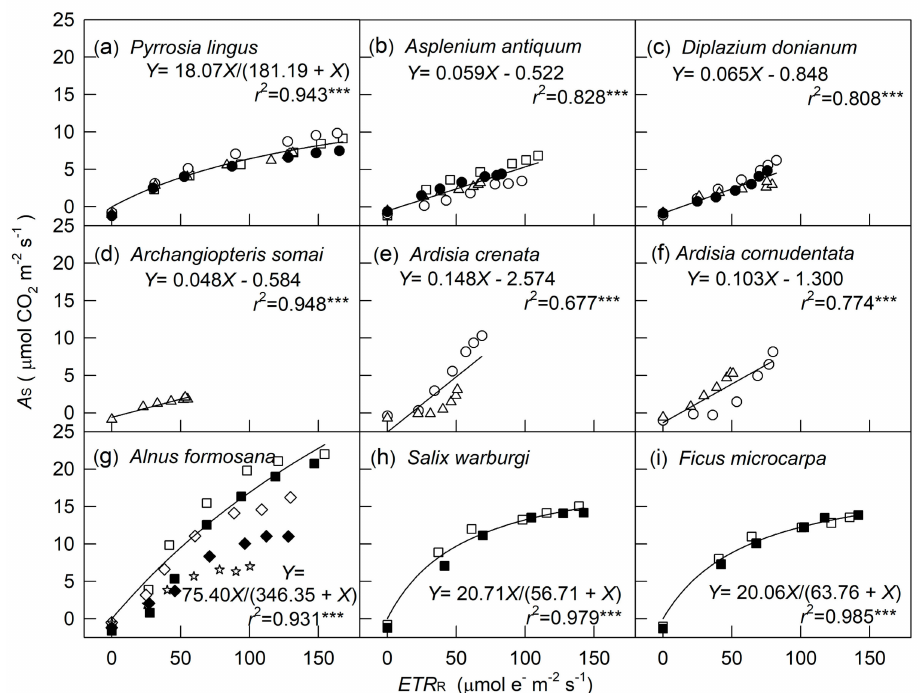
Figure 3. Relationship between net photosynthetic rate from a steady-state light response ( A S ) and electron transport rates from a rapid light response ( ETR R ) for four ferns ( a – d ), two understory shrubs ( e – f ), and three tree ( g – i ) species. Squares, circles, and triangles indicate cultivated under 100%, 50%, and 10% sunlight, respectively, and measured under well-watered conditions; diamonds and stars ( g ) indicate cultivated under 100% sunlight and measured under mild and severe drought conditions, respectively. Open and closed symbols indicate measured under 75% and 50% relative humidity, respectively, for ferns and understory shrubs, and 80% and 40%, respectively, for trees. A S of ferns and understory shrubs measured at 75% relative humidity were from [3]. The regression line in g was fitted for well-watered conditions only. *** is significant at p <